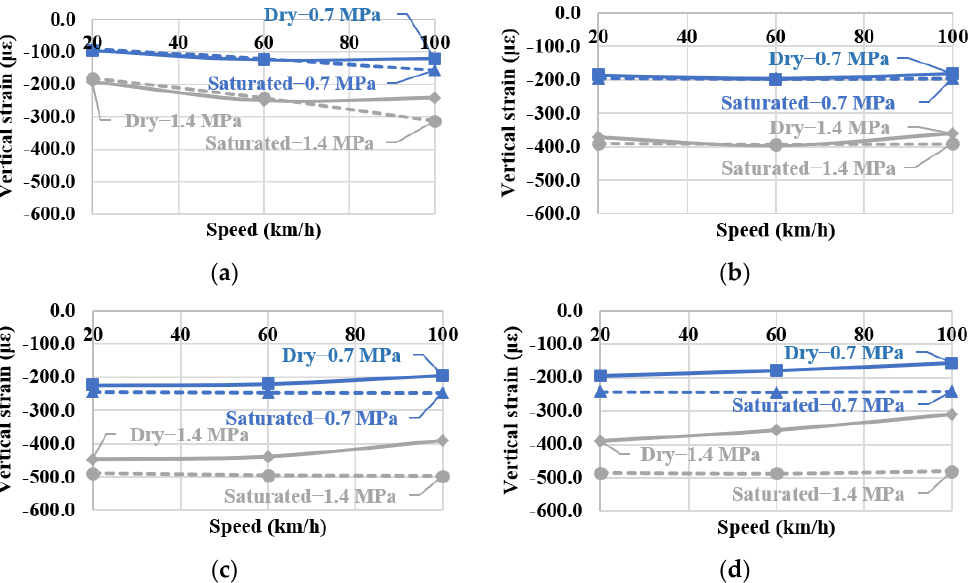
Figure 10. Variation trends of vertical strain in dry and saturated asphalt pavement: ( a ) Surface layer (h = 0m); ( b ) Upper layer bottom (h = 0.05m); ( c ) Middle layer bottom (h = 0.11m); ( d ) Lower layer bottom (h = 0.18m).